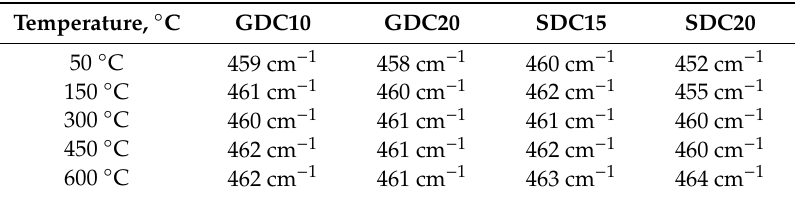
Table 2. Raman spectra of the F 2g mode peak position on the thin films deposited on SiO 2 substrate at di ff erent substrate temperatures from 50 ◦ C to 600 ◦